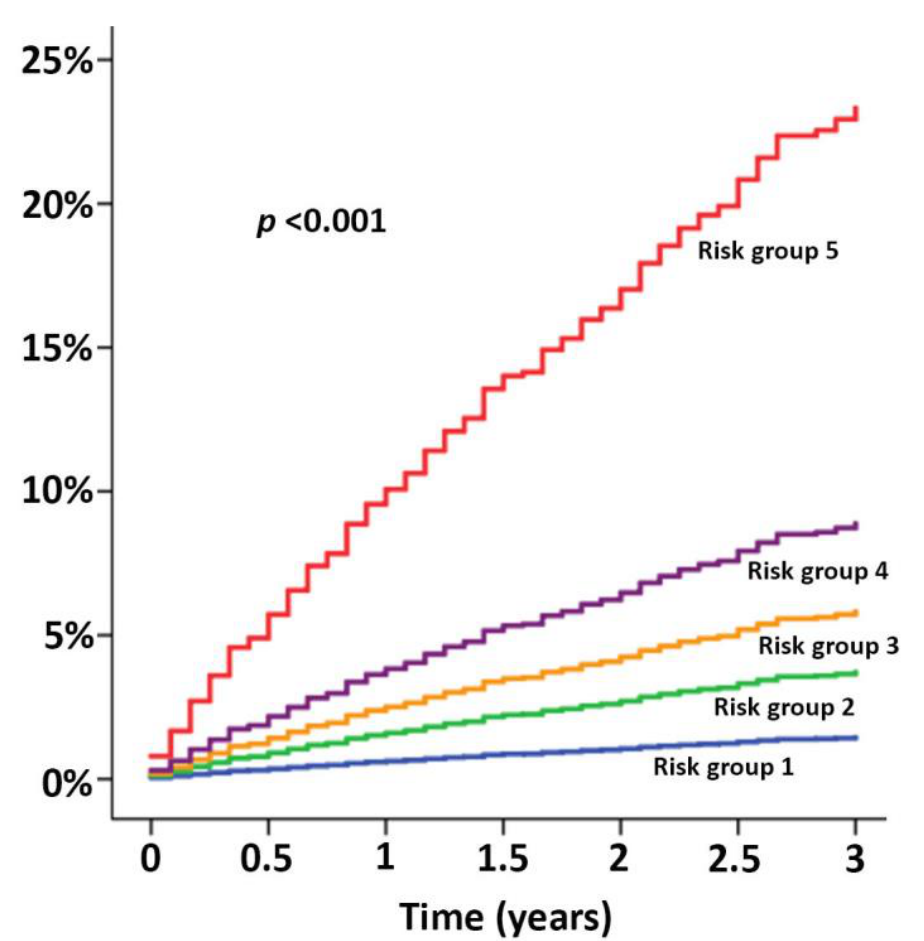
Figure 3. Hazard graph showing the risk of HF events during the 3-year follow-up stratified by the risk groups from very low risk (Risk group 1) to very high-risk (Risk group 5).